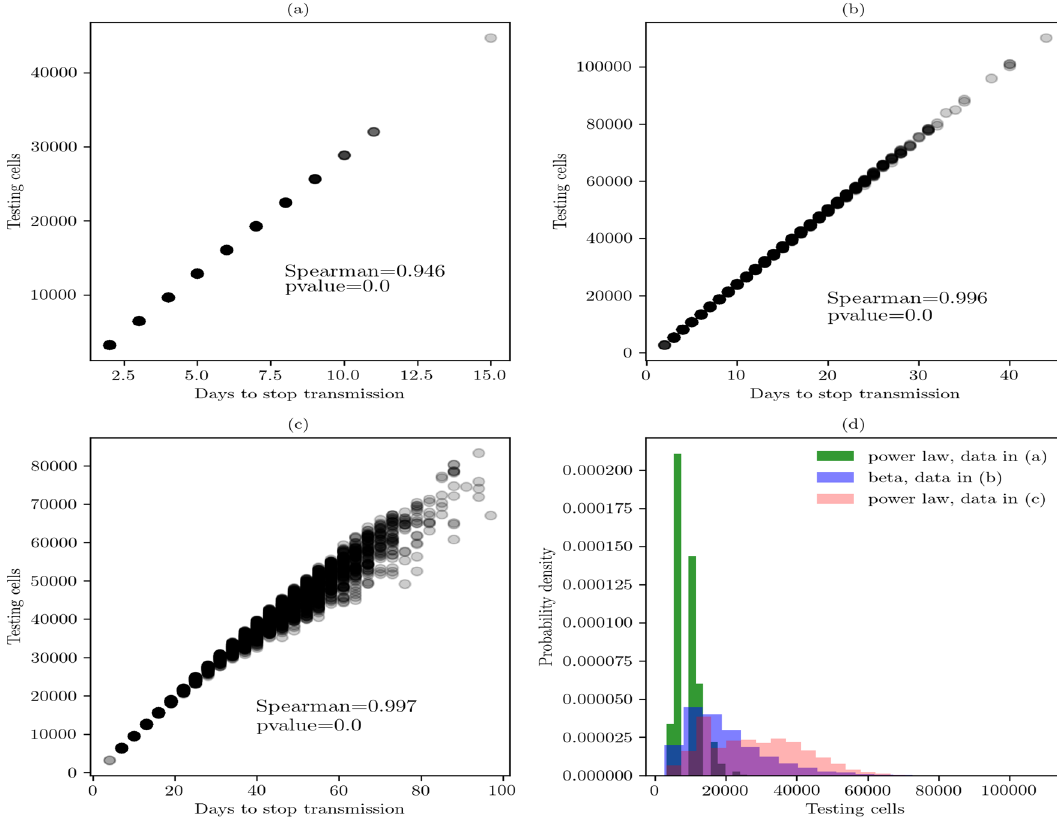
Figure 6. Sensitivity analysis based on scatterplots in the array of 60 × 60. ( a ) Daily testing-isolated and 90% of random sample. ( b ) Twice a week testing-isolated and 90% of random sample. ( c ) Daily testing-isolated and 75% of random sample. ( d ) Distribution fitting of the cost for the testing-isolated strategy in the three cases. Data in subfigures ( a ) and ( c ) is best described by a power law distribution that shows a probability density function of the form f ( x , α) = α x α − 1 , for 0 ≤ x ≤ 1 , α > 0 . Data in ( b ) is best described by a beta distribution that shows a + b ) x α − 1 ( 1 − x ) b − 1 0 < x < 1 , a > 0 , b > 0 probability density function of the form f ( x , a , b ) = γ( a γ( a )γ( b ) , for